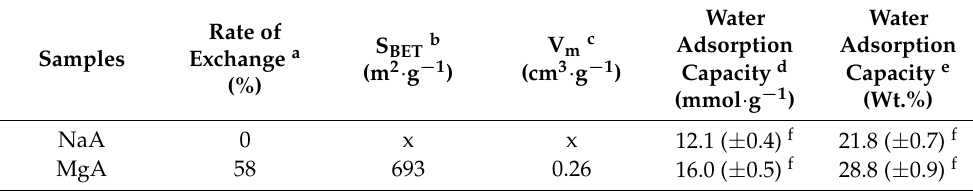
Table 2. Rate of exchange, BET surface area (SBET), microporous volume (Vm), and water adsorption capacity for the raw and exchanged LTA-type